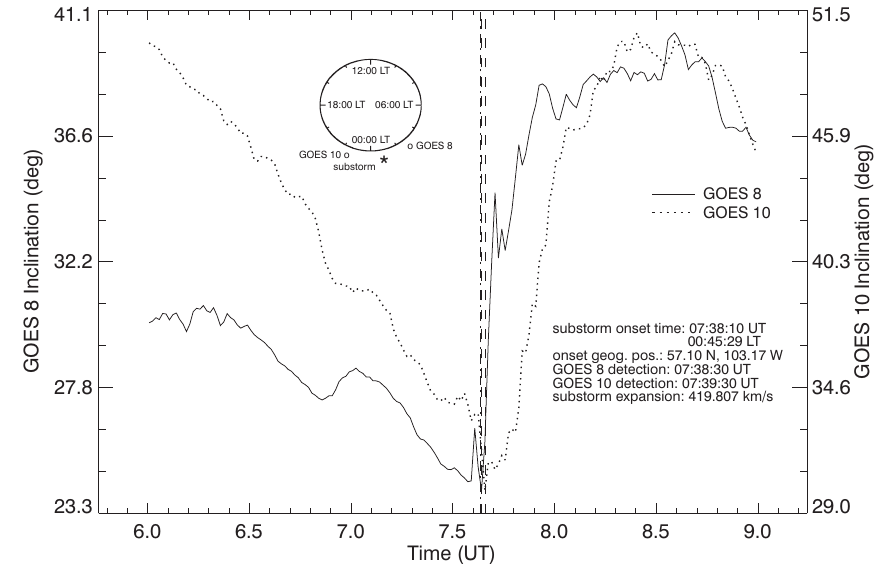
Fig. 6. Magnetic inclination calculated from GOES data showing dipolarization signatures of a substorm event on 8 May 2001.